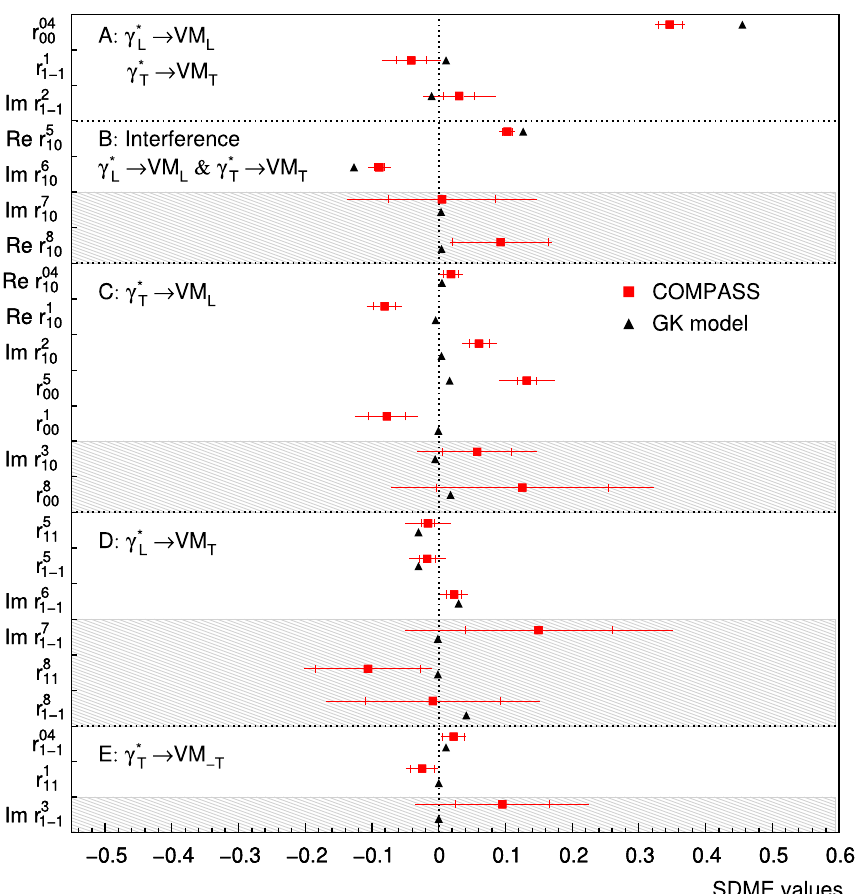
Fig. 12 Comparison of the measured SDMEs with calculations of the GPD model of Goloskokov and Kroll [12]. The calculations are obtained = 0 . 14 (GeV / c ) 2 . Inner error bars represent statistical uncertainties and outer ones statistical for Q 2 = 2 . 0 (GeV/ c ) 2 , W = 7 . 5 GeV/ c 2 and p 2 T and systematic uncertainties added in quadrature 0.39 and 0.07 for W values of 5.0 GeV/ c 2 , 7.1 GeV/ c 2